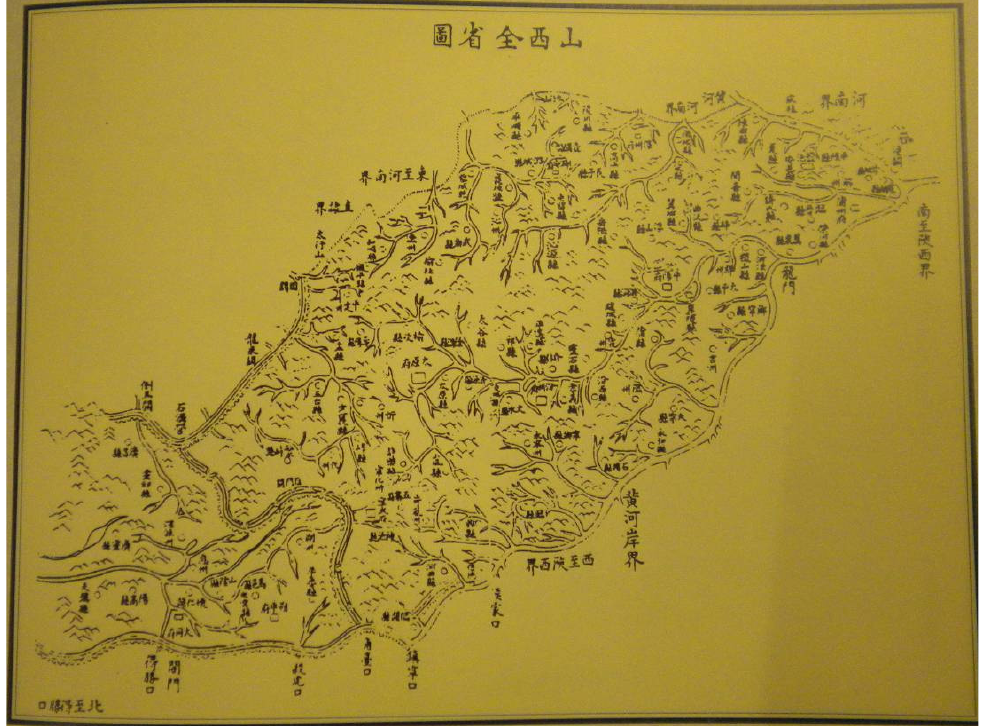
Figure 2. Map of Shanxi province in 1734. Source: Da Qing Yi Tong Zhi [ 大清一统志 ] (1734)